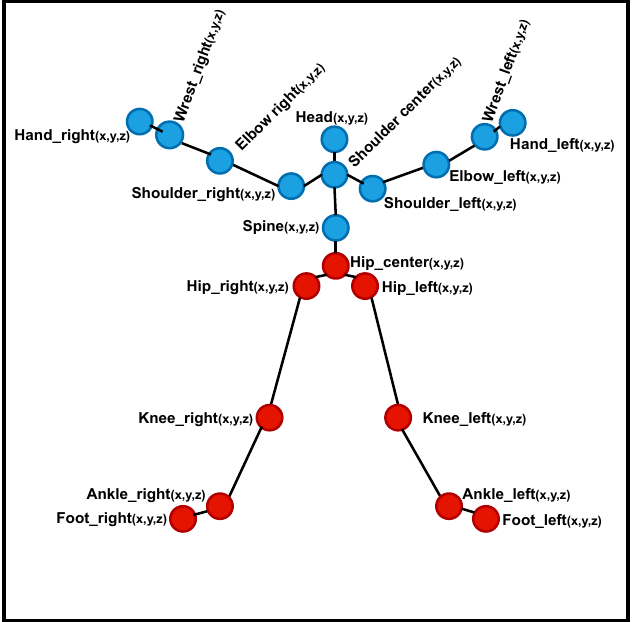
Figure 4. Various human